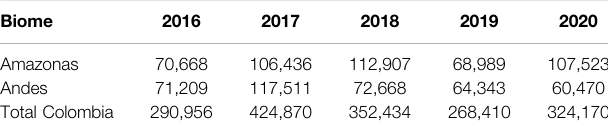
TABLE 1 | Deforestation trends in Colombian in the Post-Agreement. Source: Global Forest Watch, 2021.